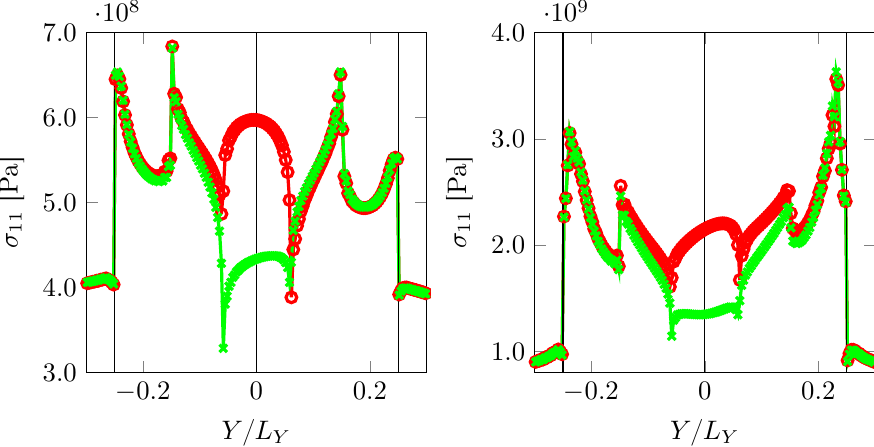
( a ) Distribution of σ 11 . Red and green curves represent resulting profiles for hard and soft martensite variants between O 1 O 2 , respectively.